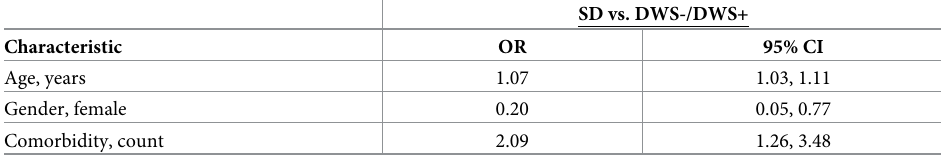
Abbreviations: CI, confidence interval; OR, odds